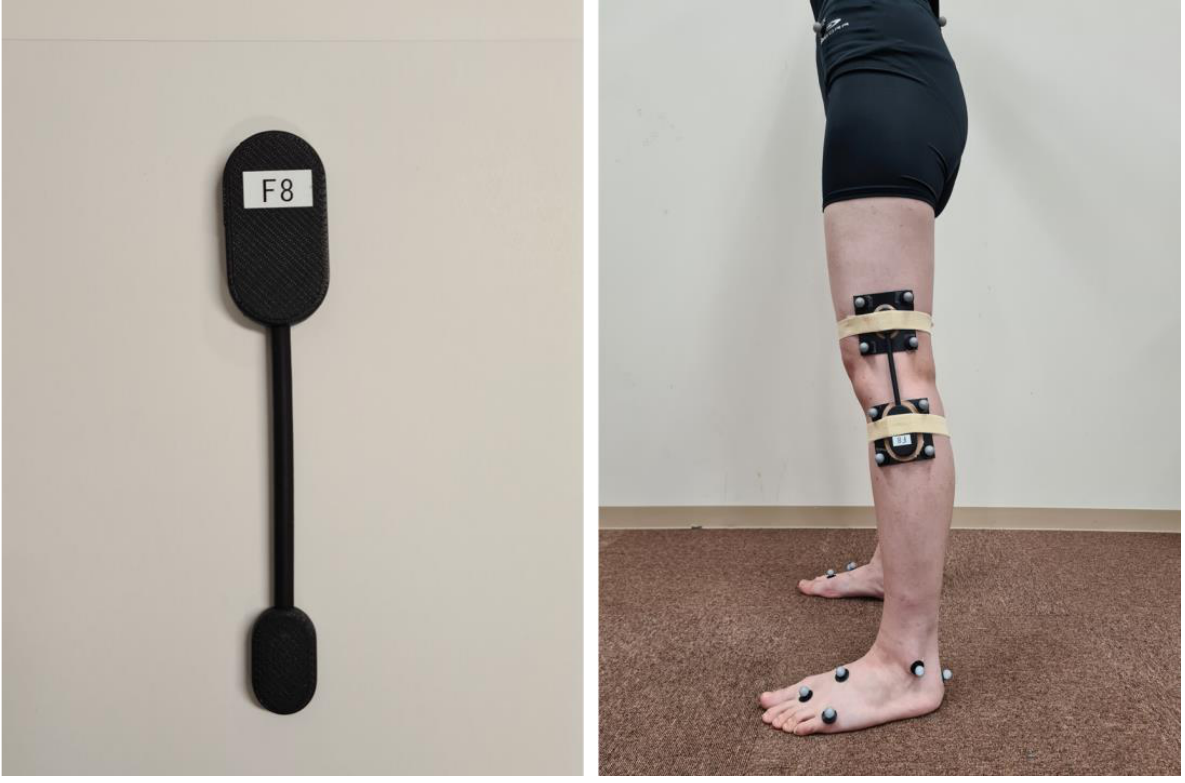
Figure 1. Attachment of the wearable goniometer. Calibration trials were performed in standing and sitting positions. The knee flexion angle measured during the standing trials was defined as neutral (i.e., zero degrees). The knee flexion angle in the sitting position was measured via digital photography using the mobile application (Figure 2). The knee flexion angle during the motion task was determined using the linear fitting coefficient obtained from the two calibration trials on the mobile application. The knee flexion angle was sampled at 200 Hz, exported as a database file, and then as a CSV file with sensor address, time stamp, and trial name. The data were smoothed using a fourth-order Butterworth lowpass filter with a cut-off frequency of 6 Hz at post-processing using MATLAB (MathWorks, Natick, MA,